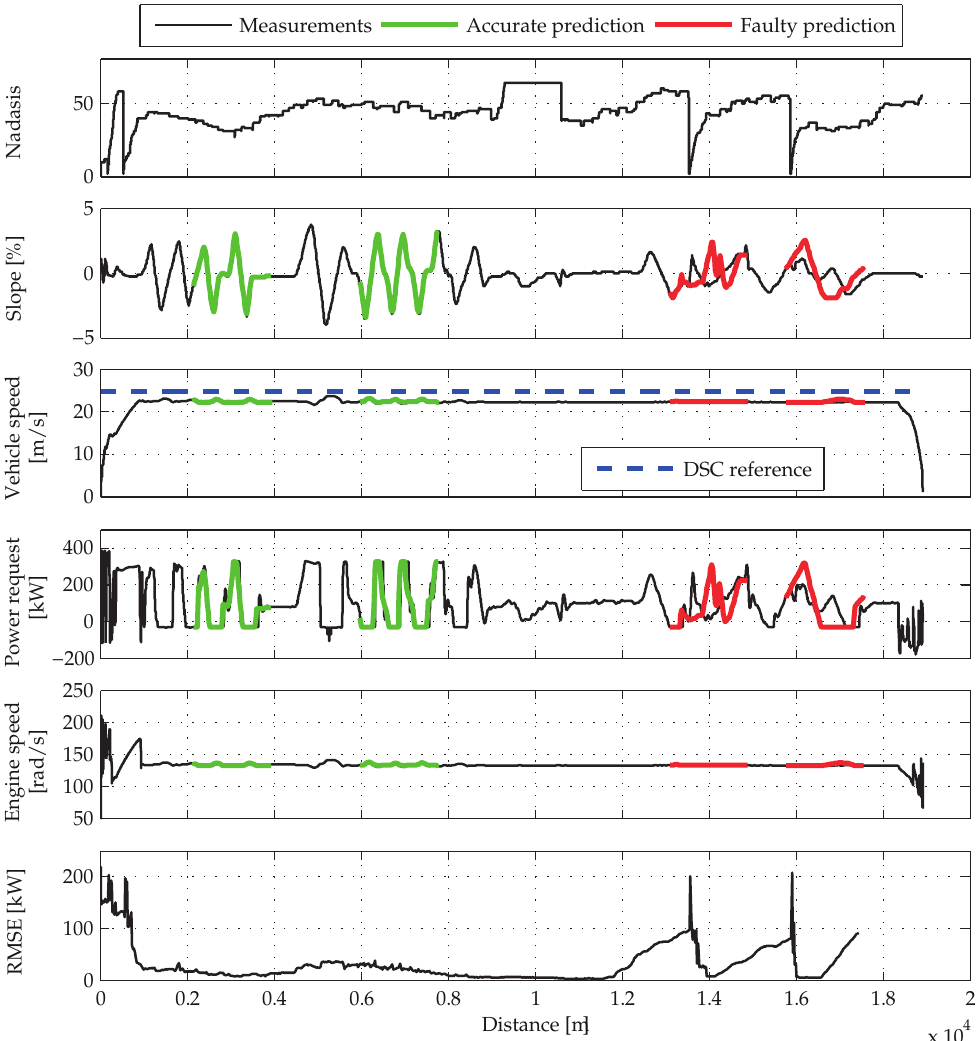
Figure 10. Road load prediction with Algorithm 2 and